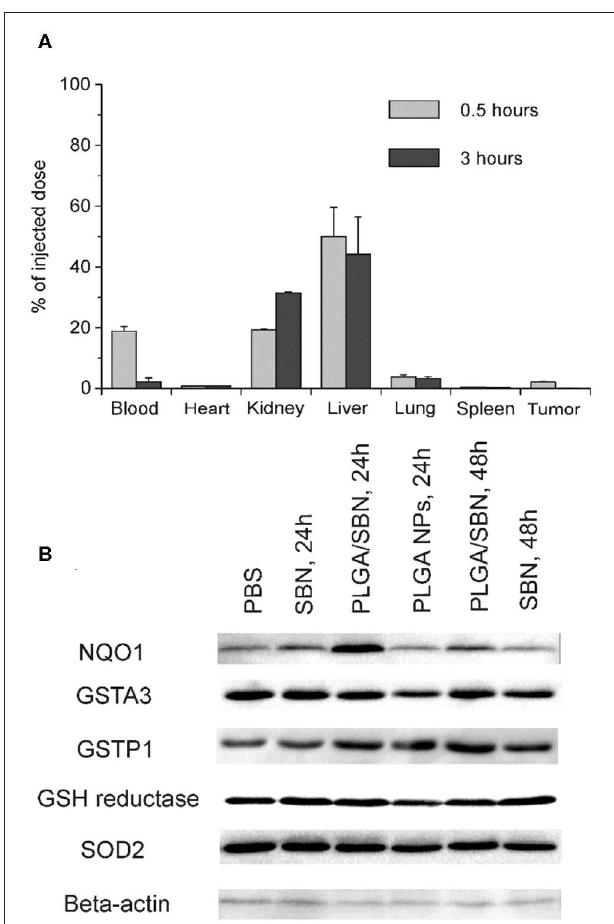
FIGURE 3 | PLGA nanoparticle biodistribution and upregulation of phase II enzymes by SBN-containing formulations. (A) Analysis of PLGA/rhodamine nanoparticle biodistribution in different tissues of B16F1 tumor-bearing mice upon intravenous administration. All values are shown as means ± SD. (B) Expression levels of phase II and antioxidant enzymes in liver tissue of mice treated with SBN formulations, determined by Western blotting